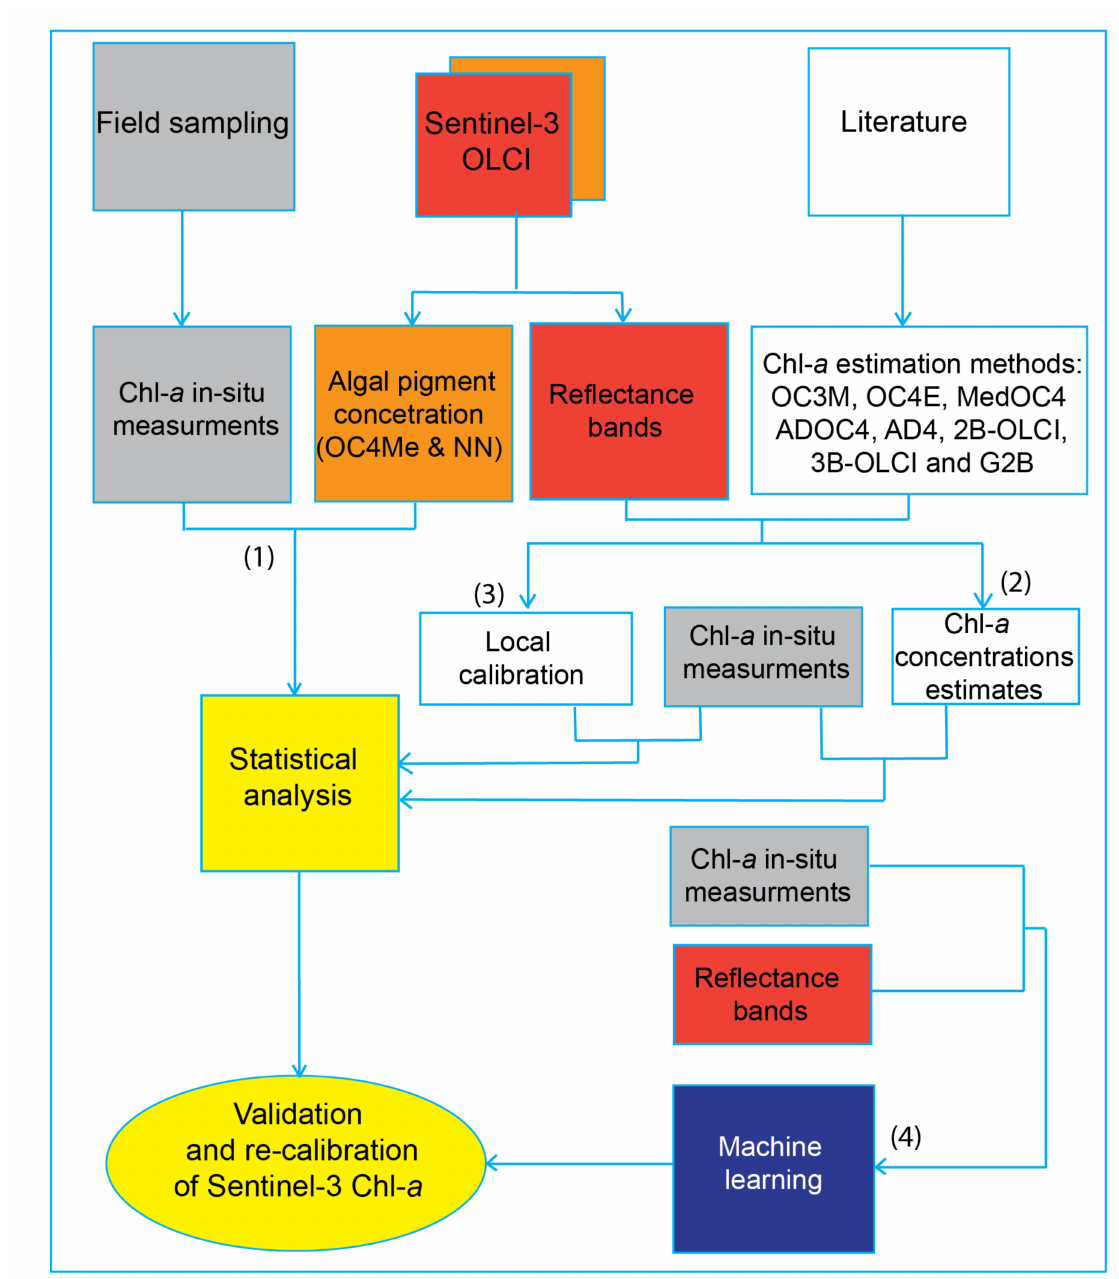
Figure 2. Flowchart of the evaluation of Sentinel-3 OLCI data using several different methods. The four important steps of this study are presented: ( 1 ) Chl- a OLCI level 2 products (OC4Me and NN) were evaluated at sampling station locations and compared to in-situ measurements, ( 2 ) eight known methods for estimating of Chl- a concentration based on reflectance values were tested (OC3M, OC4E, MedOC4, ADOC4, AD4, 3B-OLCI, 2B-OLCI and G2B), ( 3 ) localized calibration was performed for seven known methods (OC3, OC4, AD4, G2B, 2B-OLCI, 3B-OLCI) and ( 4 ) a L1-regularized regression and a random forests machine were trained on in-situ